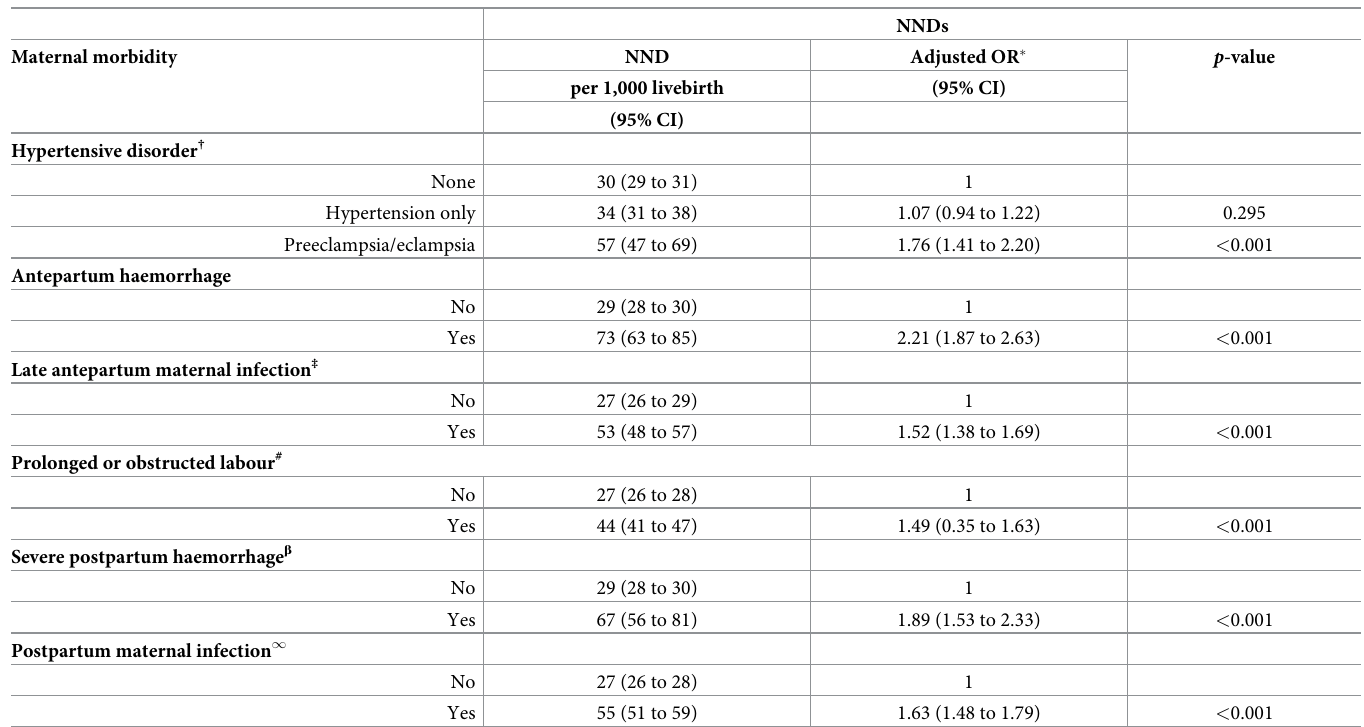
Table 5. Adjusted association of maternal morbidities with